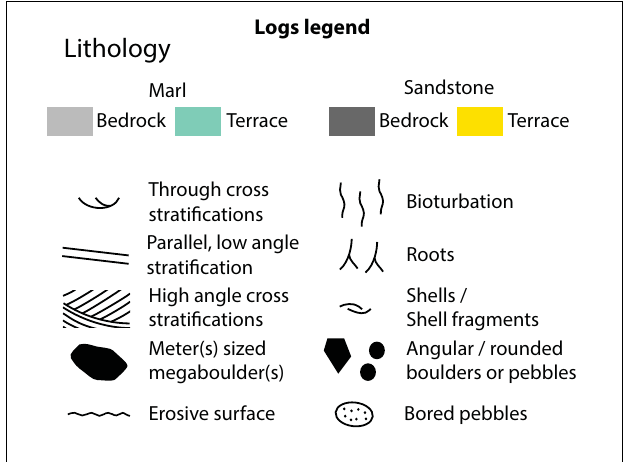
FIGURE 5 | Legend of the logs in Figure 6